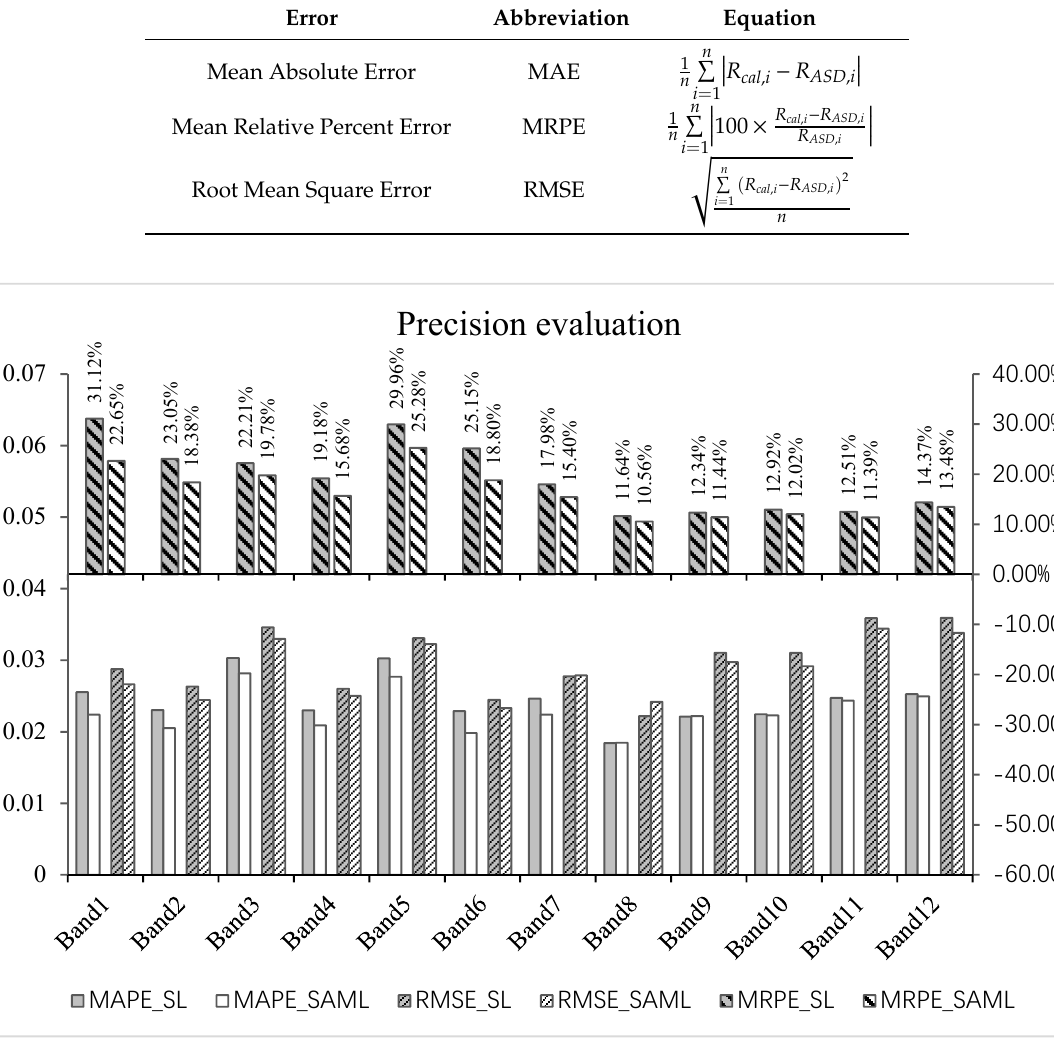
Figure 10. Precision evaluation of ELM and SACM.